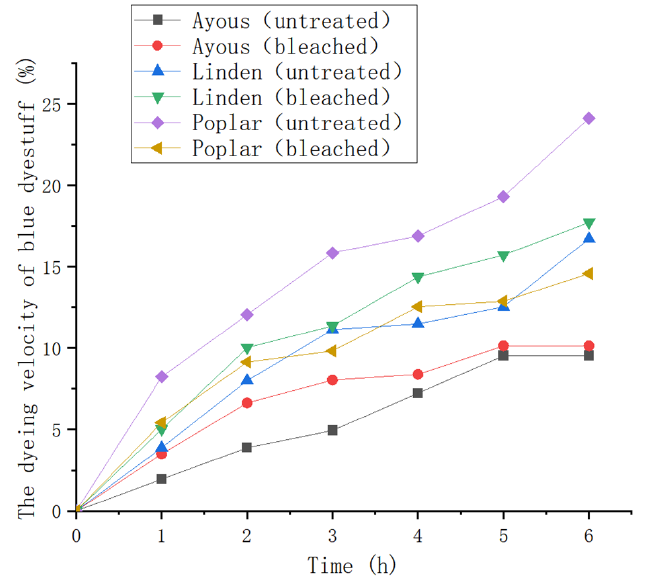
Figure 7. Dyeing rate of blue dyestuff.